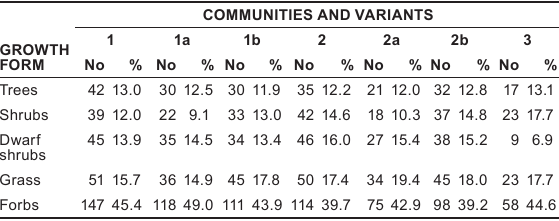
table 3 Species richness within the communities and their associated variants according to each growth form